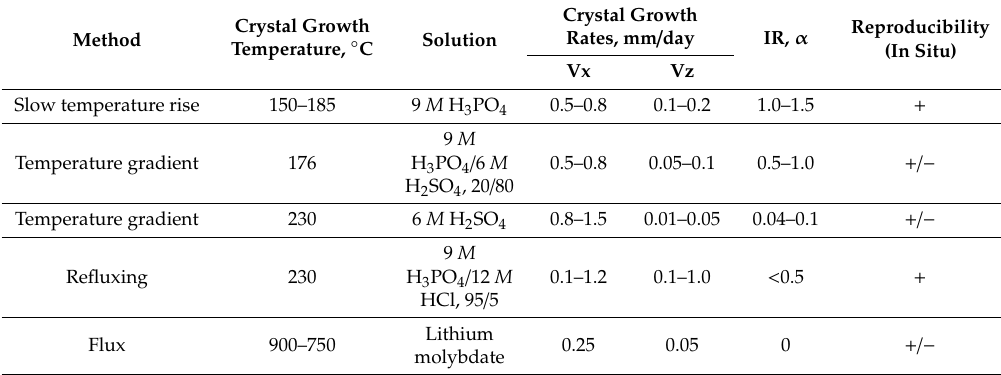
Table 2. Comparative alpha values of GaPO 4 crystals grown by temperature gradient, slow temperature rise, refluxing hydrothermal methods and by flux